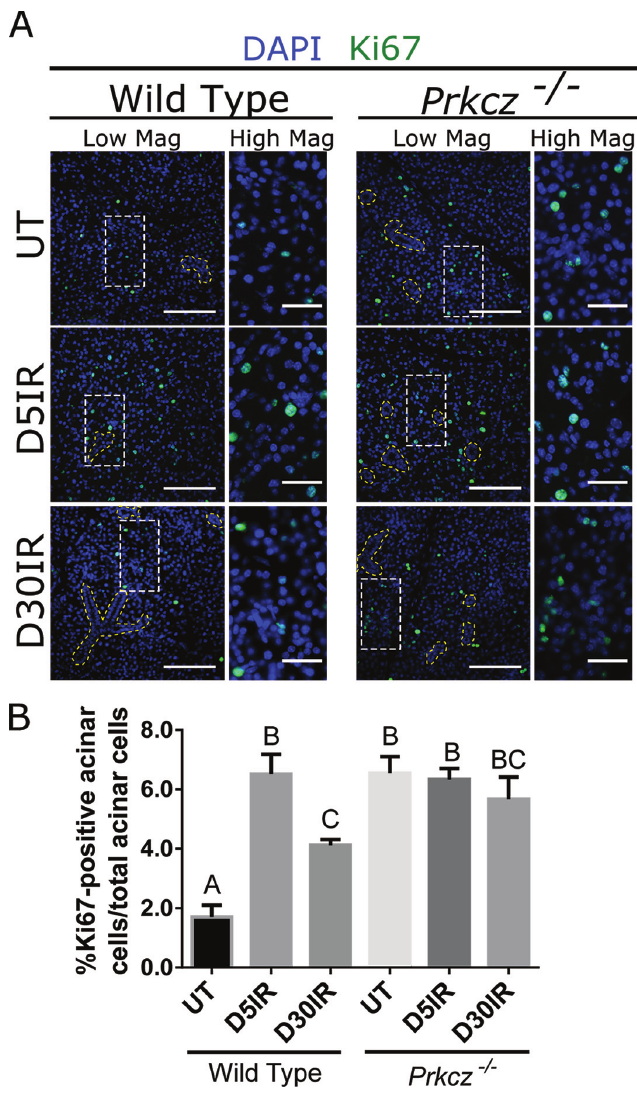
Fig 2. Depletion of PKC z induces proliferation in vivo . Wild Type C57BL/6J and Prkcz -/- mice were either untreated (UT) or irradiated (IR) with 5Gy and dissected on days 5 and 30 following radiation treatment. (A) Immunofluorescent staining with Ki67 (green) was used to determine the number of proliferating cells in comparison to the total number of cells in the acinar compartment. Composite images with DAPI (blue) are presented in both high and low magnification views (scale bar for high magnification = 30 μ m, low magnification = 100 μ m). The yellow dotted outline represents the ductal compartment while the rest of the glandular area represents the acinar compartment. (B) Quantification of A. Results are presented from at least four mice per condition; A-B used 10–15 images per mouse; error bars denote mean ± SEM. Significant difference (p < 0.05) was determined by a Tukey-Kramer test for multiple comparisons. Treatment groups with different letters above the bar graphs are significantly different from each